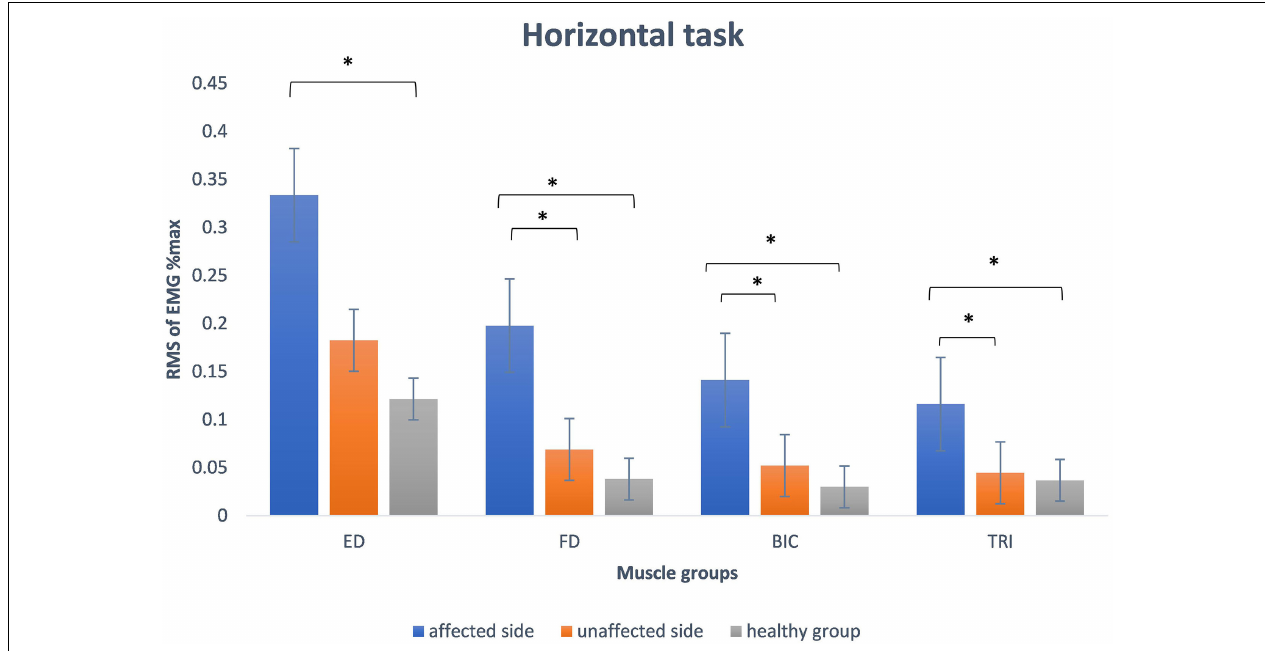
FIGURE 3 | The mean and standard deviation of root mean square of EMG data of all participants during horizontal task involved in the study. The significant difference between the groups is indicated by ( ∗ p < 0.05 with one-way ANOVA). ED, extensor digitorum; FD, flexor digitorum; BIC, biceps brachii; TRI, the triceps